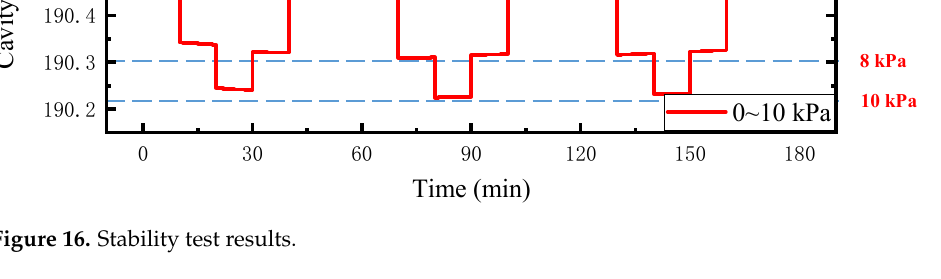
Figure 16. Stability test results.